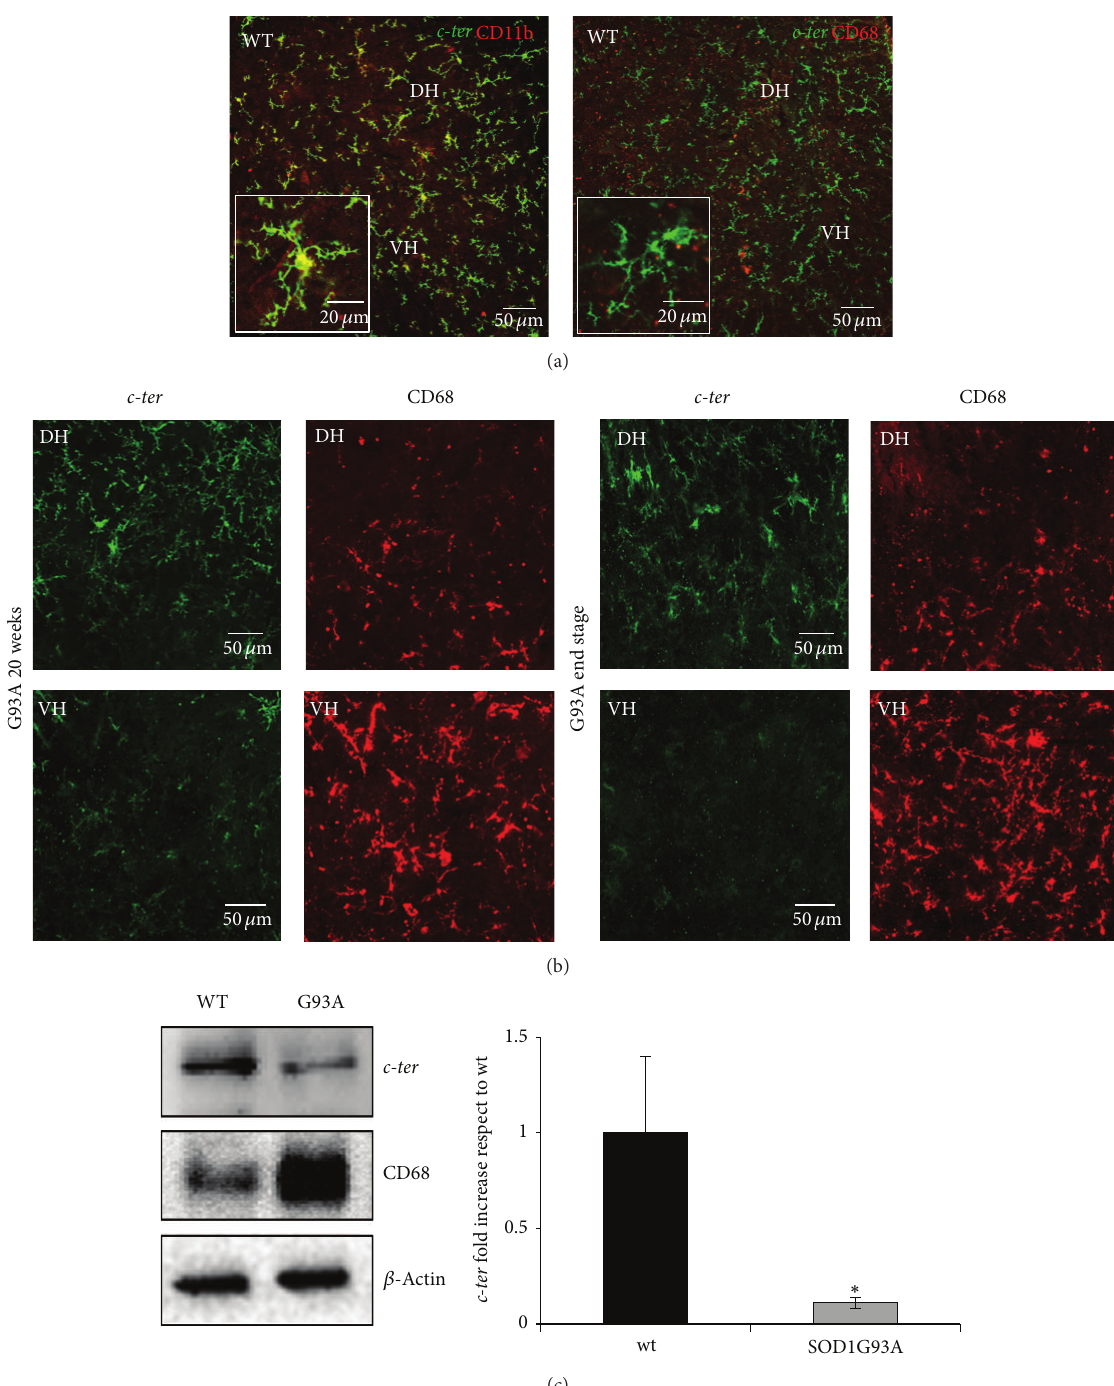
Figure 4: Temporal and regional pattern of P2Y 12 expression in SOD1-G93A ALS spinal microglia. (a) Double immunofluorescence and confocal analysis on lumbar spinal cord sections (L3–L5) of wild-type (WT) mice was performed with c-ter antibody (green and yellow, merged and insets), CD11b (left panel, yellow, merged and inset), and CD68 (right panel, red, merged and inset), in both dorsal (DH) and ventral (VH) horns of spinal cord. (b) Double immunofluorescence and confocal analysis on SOD1-G93A lumbar spinal cord sections (L3–L5) at two different stages of ALS disease, that is, 20 weeks, and end stage, was performed with c-ter (green) and CD68 (red) antibodies. (c) Equal amount of total lumbar spinal cord lysates (L3–L5) from WT and SOD1-G93A ( 𝑛 = 4 for each group) were subjected to Western blotting and immunoreactions with c-ter and CD68 antibodies; anti- 𝛽 -actin was used for protein normalization. Data represent means ± SEM. Statistical significance was calculated by Student’s 𝑡 -test, ∗ 𝑃 < 0.05